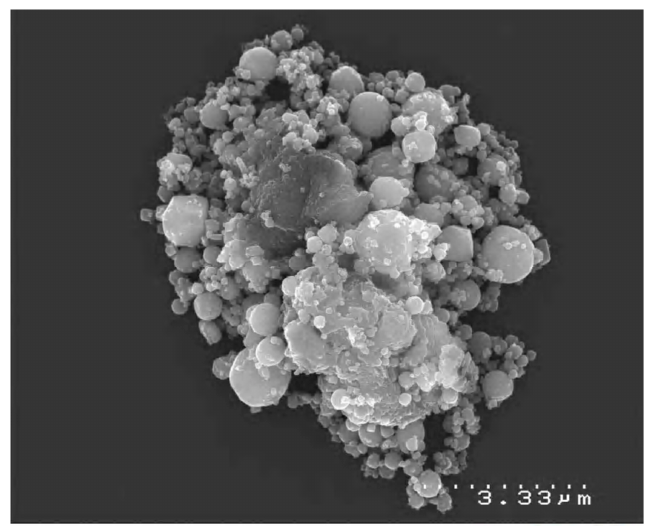
Figure 1. Scanning Electron Micrograph of typical EAF (electric arc furnace) dust.